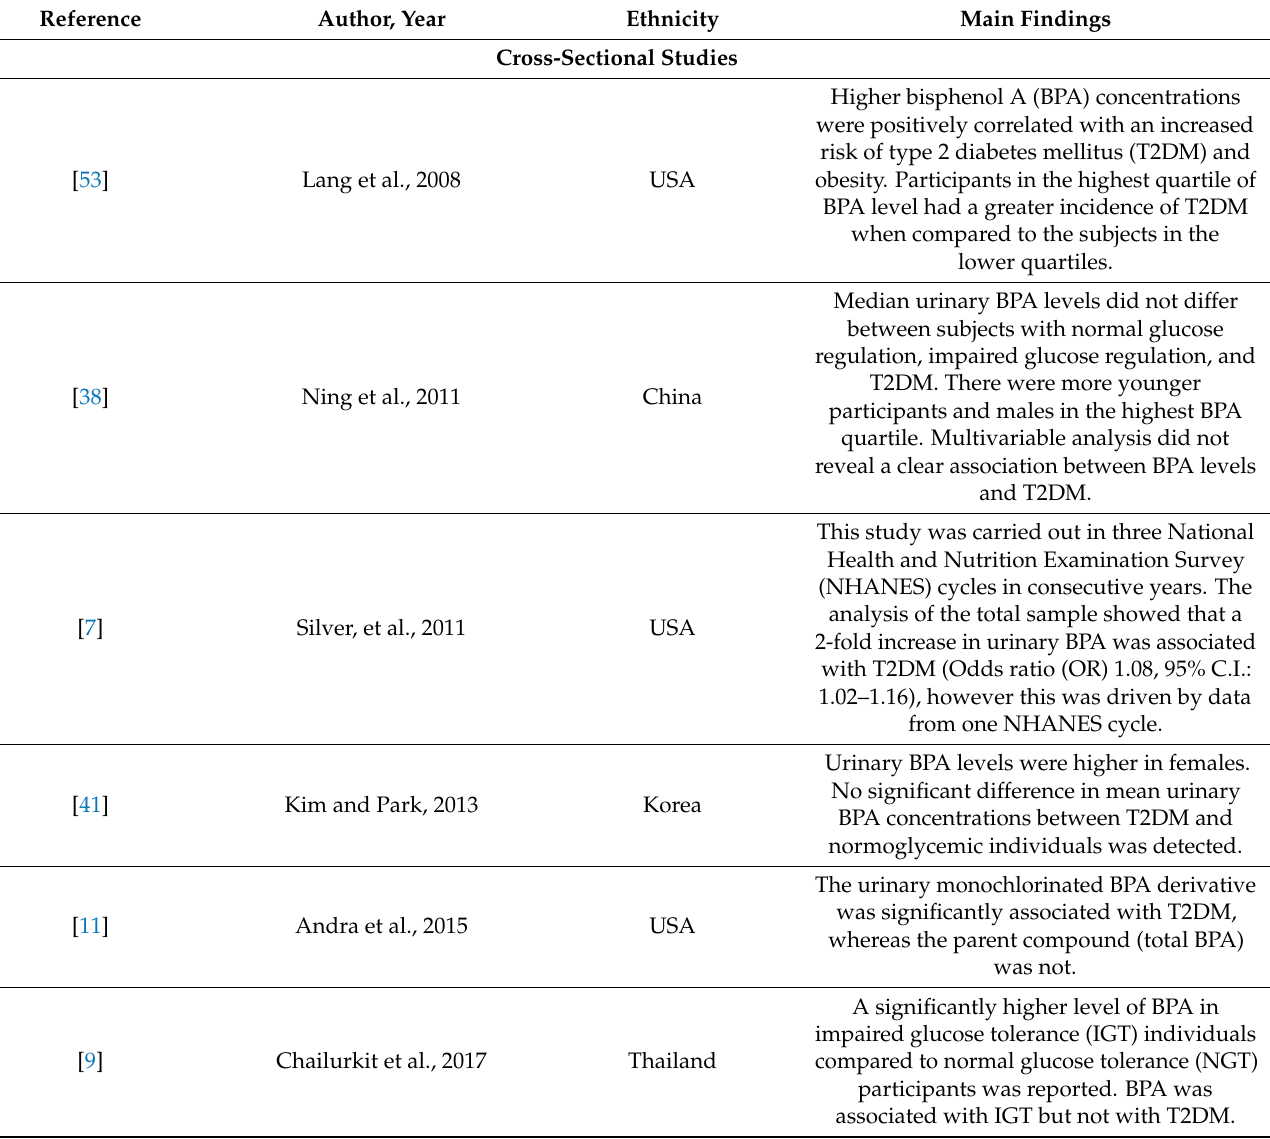
Table 1. Summary of the main findings of the epidemiological studies obtained through the literature